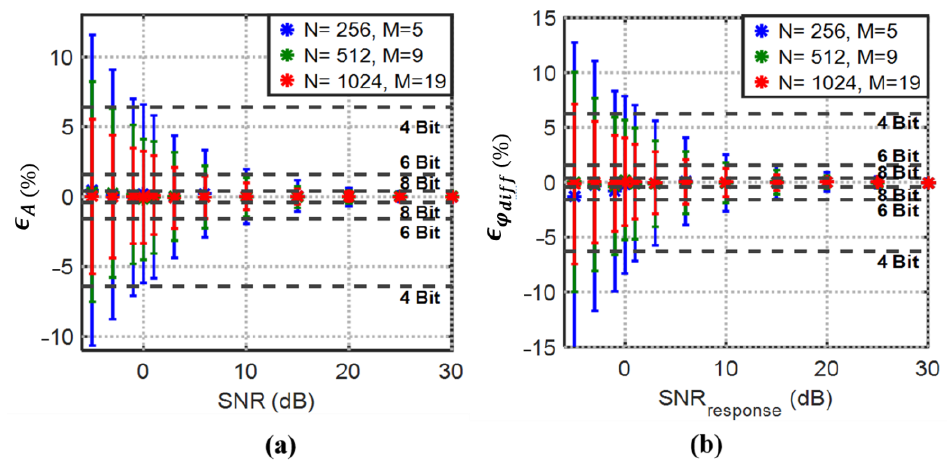
Figure 7. 3PSF ( a ) percent mean amplitude and ( b ) percent mean differential phase estimation errors with their normalized standard deviations (error bars) vs. SNR. Normalized to full-scale resolution lines demonstrate the best achievable resolution by considering the standard deviation (error bars) with the degrading SNR and increasing record length (N ).